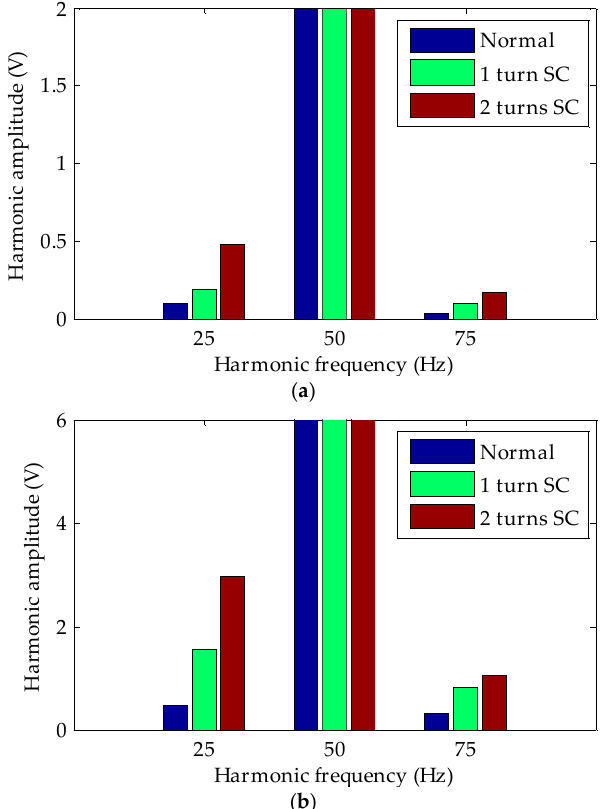
Figure 8. Induced voltage spectrum for detection coils with different short circuit degrees: ( a ) no-load; ( b ) rated load.